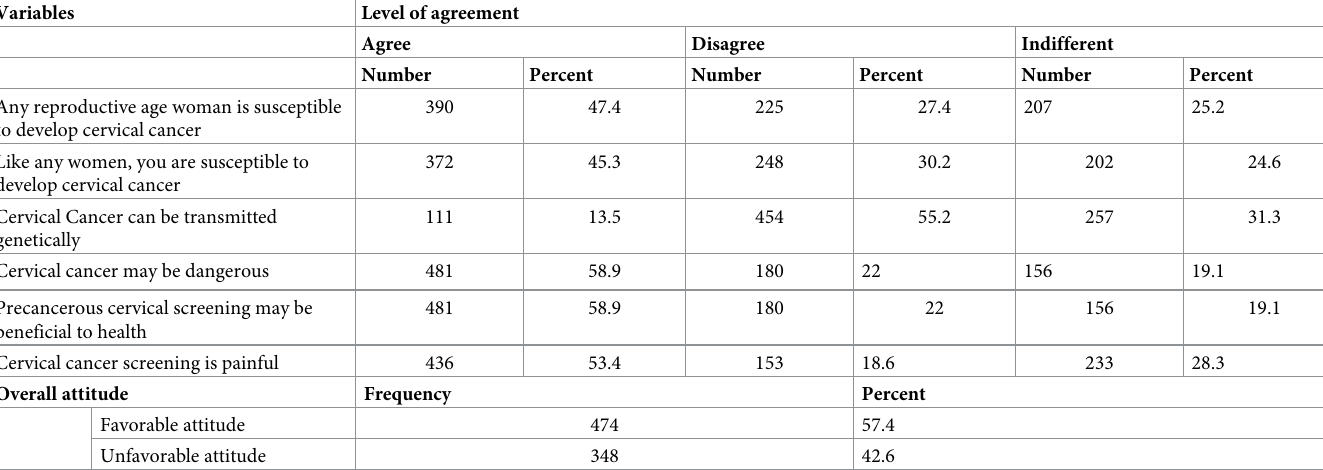
Table 4. Attitude towards cervical cancer screening among women (n = 822) in Debremarkos town, Northwest Ethiopia, 2018.